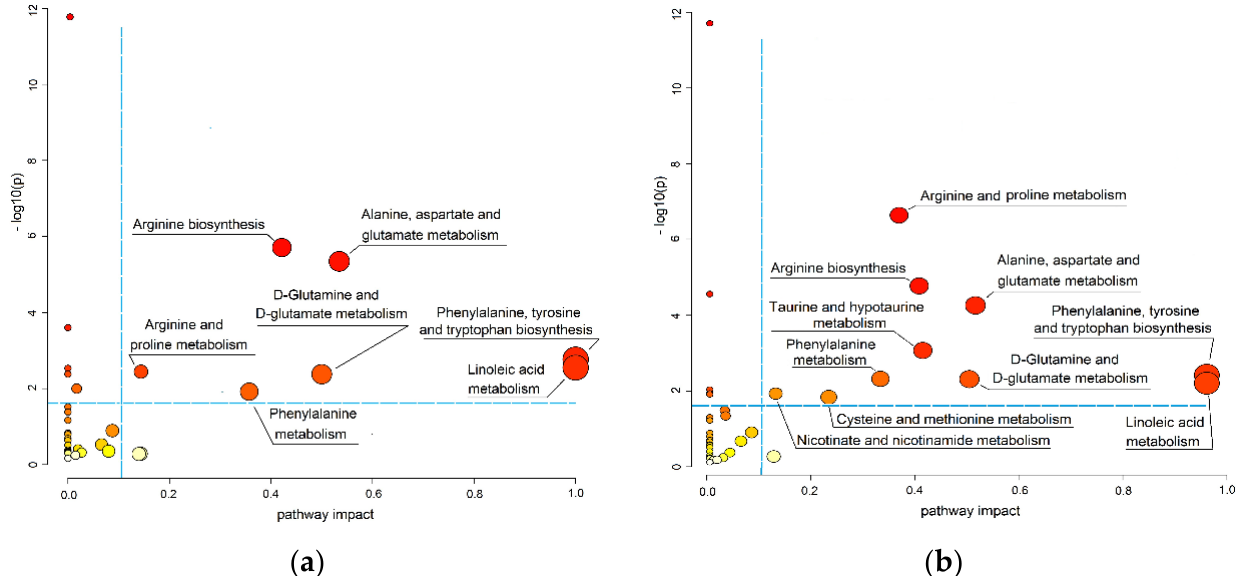
Figure 2. Pathway analysis (MetPA) of metabolites associated with different stages of ccRCC (KEGG database was used): ( a ) Metabolic pathways associated with I ‐ II stages ccRCC; ( b ) Meta ‐ bolic pathways associated with III ‐ IV stages ccRCC. The y ‐ axis—the negative natural logarithmic value of the original p ‐ value, which indicates the pathway enrichment analysis. The x ‐ axis indi ‐ cates the impact values representing pathway topology analysis. The identified pathways are dis ‐ played as circles. The color of the circles is correlated with negative log(p) values (dark red indi ‐ cates a highly significant, light yellow—insignificant), the size of the circles indicates the pathway impact value (an increase in the size is associated with the growth of impact value). The negative log(p) values lower than 1.5 ( p ‐ values lower than 0.05) and impact values 0.1 were taken as the thresholds.